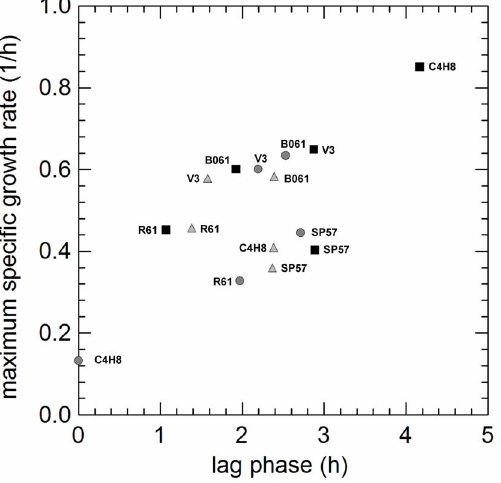
Figure 5. Relationships between maximum specific growth rates (Y-axis) and lag phases (X-axis) estimated in 5 L.paracasei strains (B061, C4H8, R61, SP57, V3) cultivated in anaerobiosis (light grey circles), aerobiosis (grey triangles) and respiratory (black squares) promoting condition.